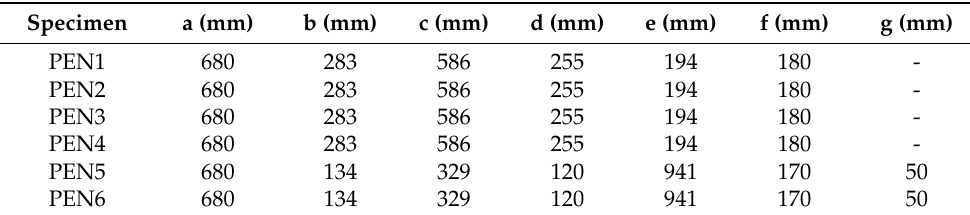
Figure 1. Cross ‐ section shape of the specimens. ( a ) 2 ‐ cell specimens; ( b ) 4 ‐ cell specimens.